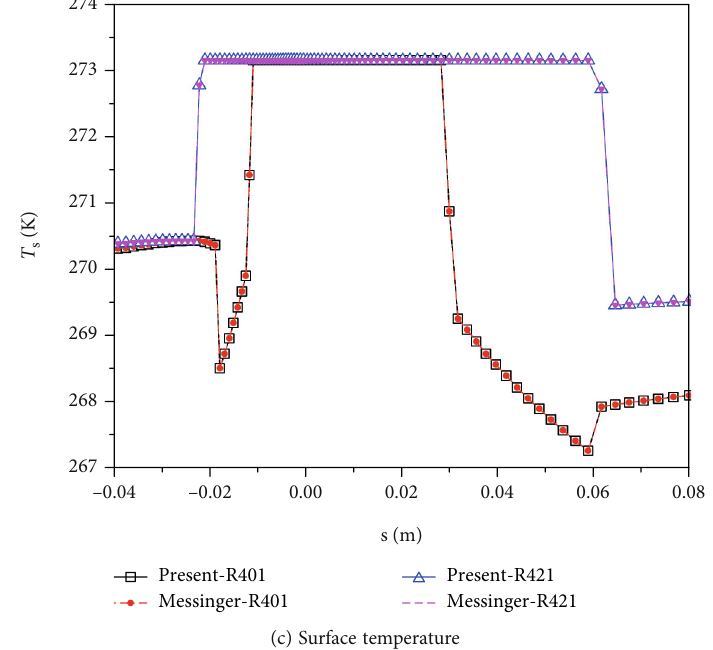
Figure 7: Comparison of icing results between the unsteady model and the Messinger